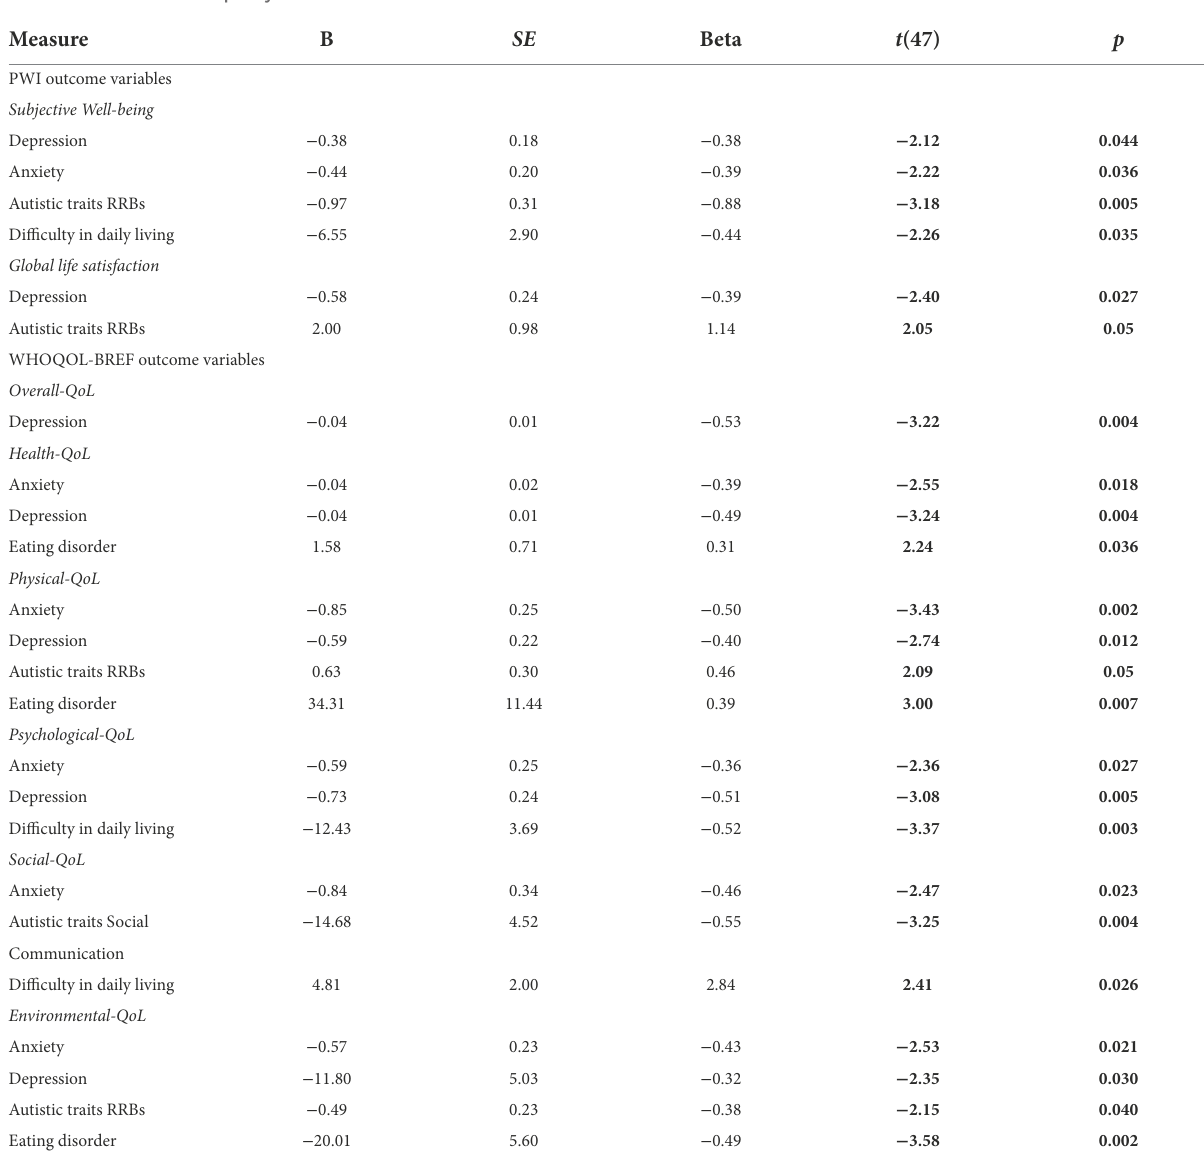
TABLE 7 T2 Predictors of quality of